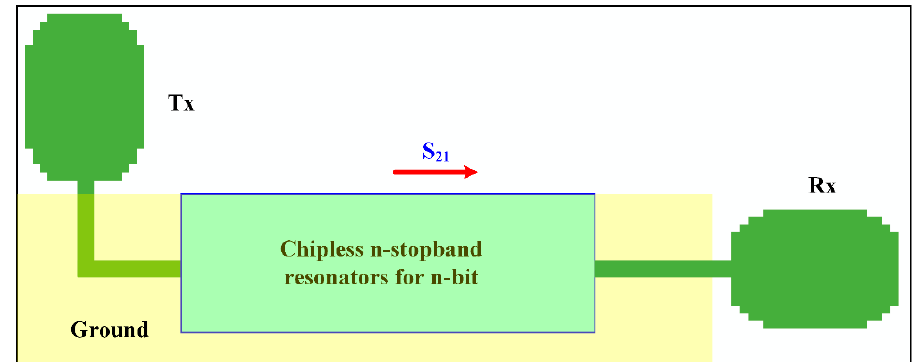
Figure 1. Simple block diagram of retransmission chipless radio frequency identification (RFID) tag.